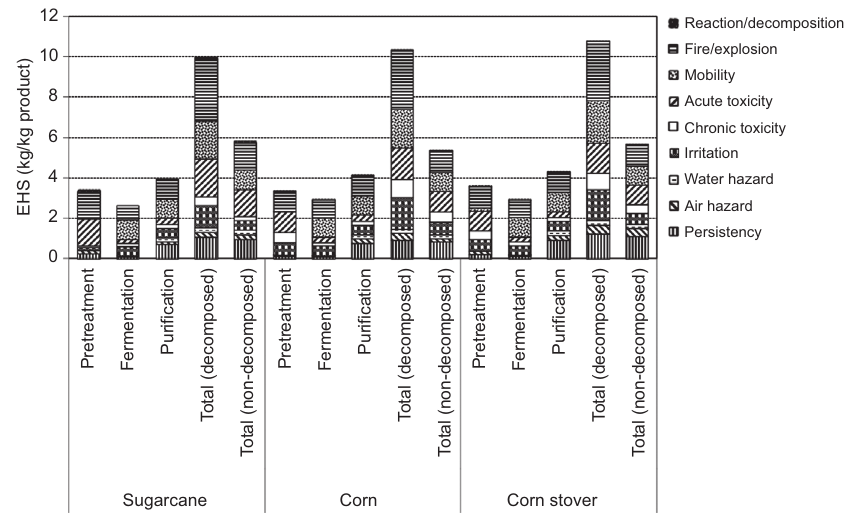
Figure 3 EHS hazard metric of alternative bioethanol production